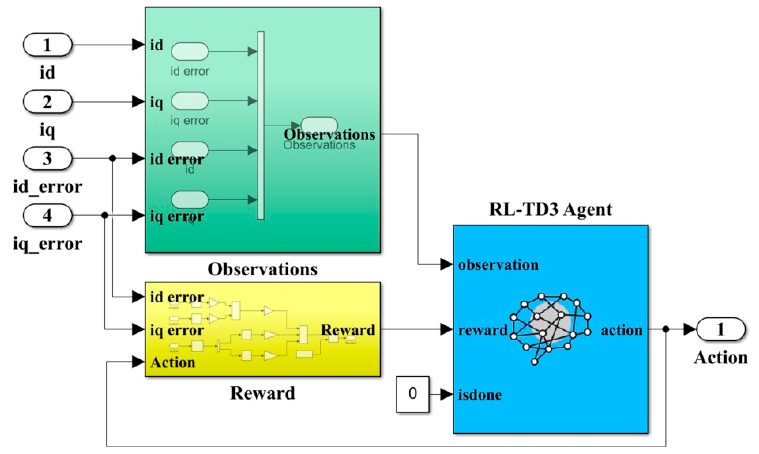
Figure 9. MATLAB/Simulink implementation of the RL-TD3 agent for the correction of u dref and u qref .